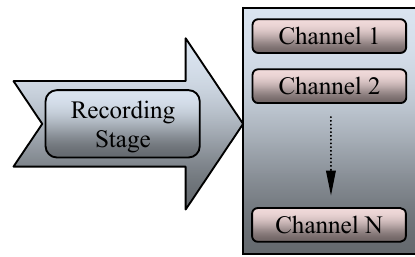
Figure 5. The multi-channel recording